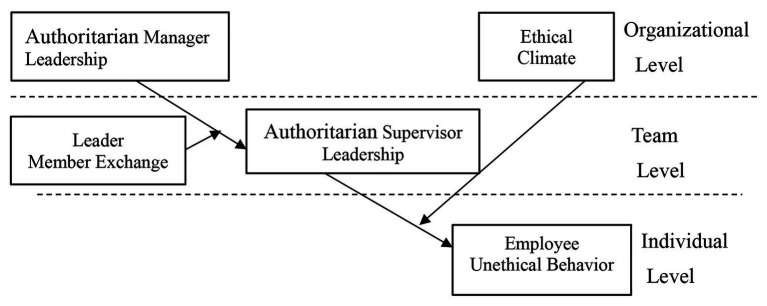
Theoretical model.